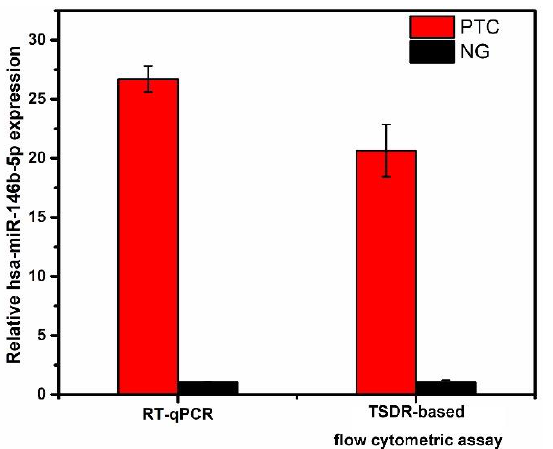
Figure 8. Relative expression levels of has-miR-146b-5p in PTC tissues and NG tissues obtained by the TSDR-based flow cytometric assay and RT-qPCR analysis. Error bars indicate the standard deviations ( n = 3).